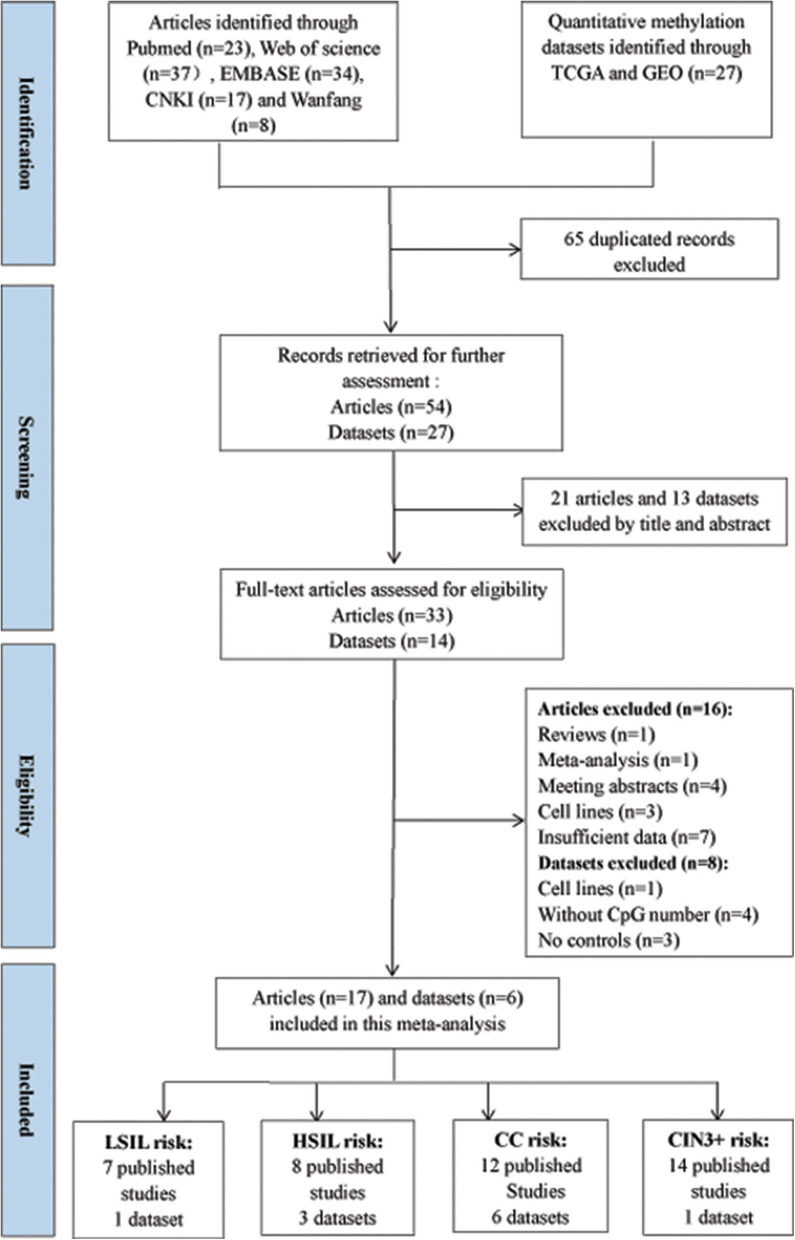
Flow diagram for the procedures of eligible studies selection in this meta-analysis.